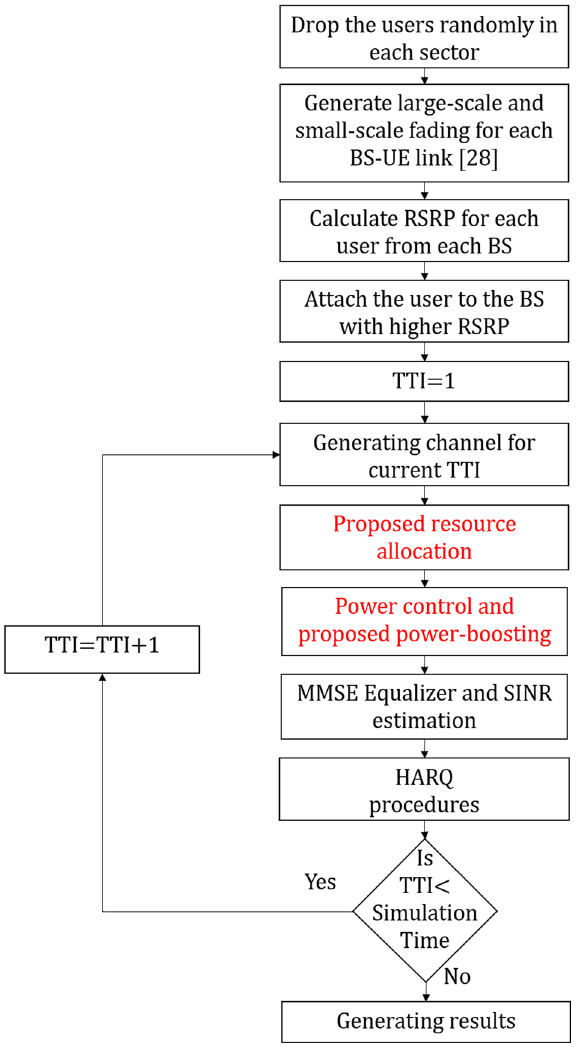
Fig. 10 Overview of the simulation